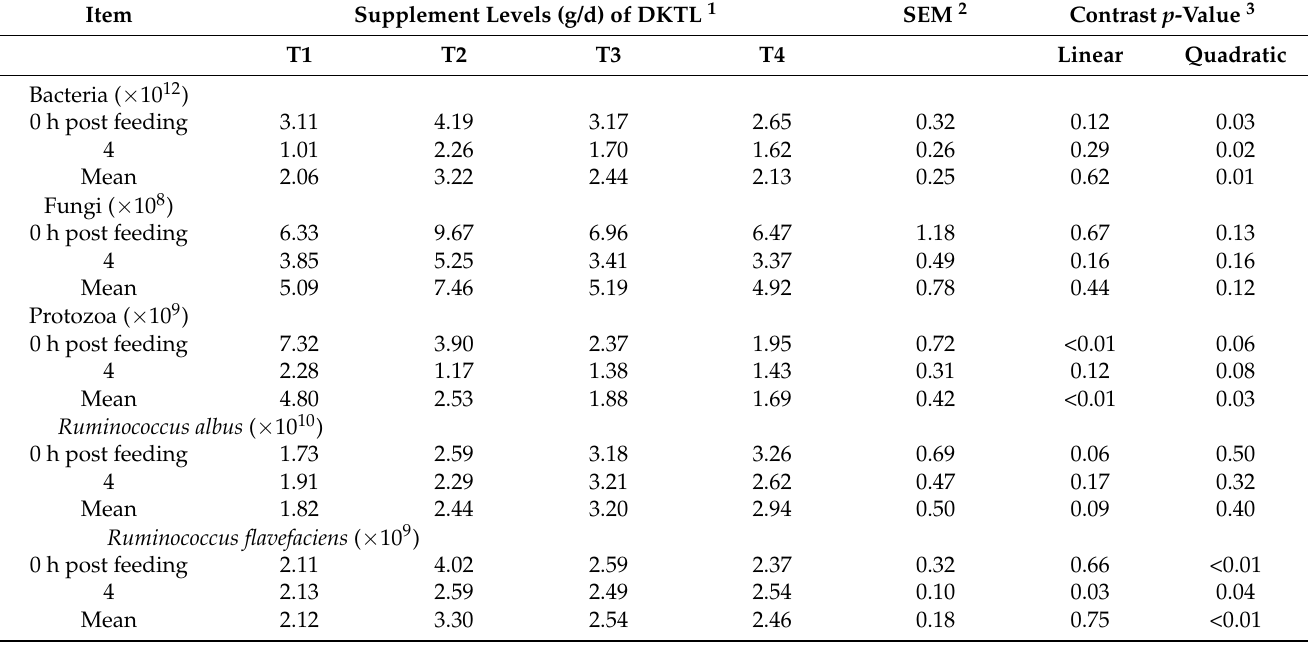
Table 9. Effects of supplement levels (g/d) of dried kratom leaves on predominant cellulolytic bacterial, fungal, and protozoal population (copies/mL of rumen content) from in the rumen fluid of